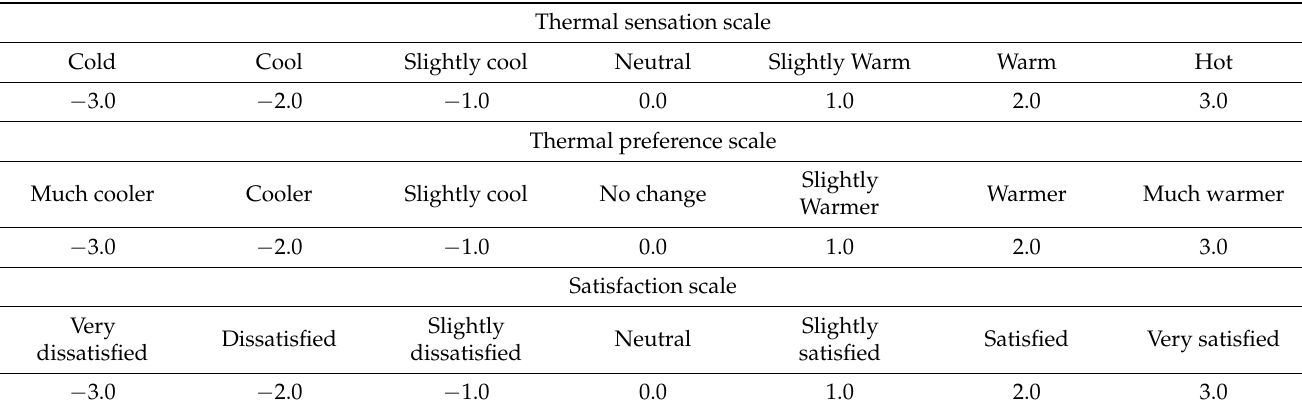
Table 2. Thermal sensation